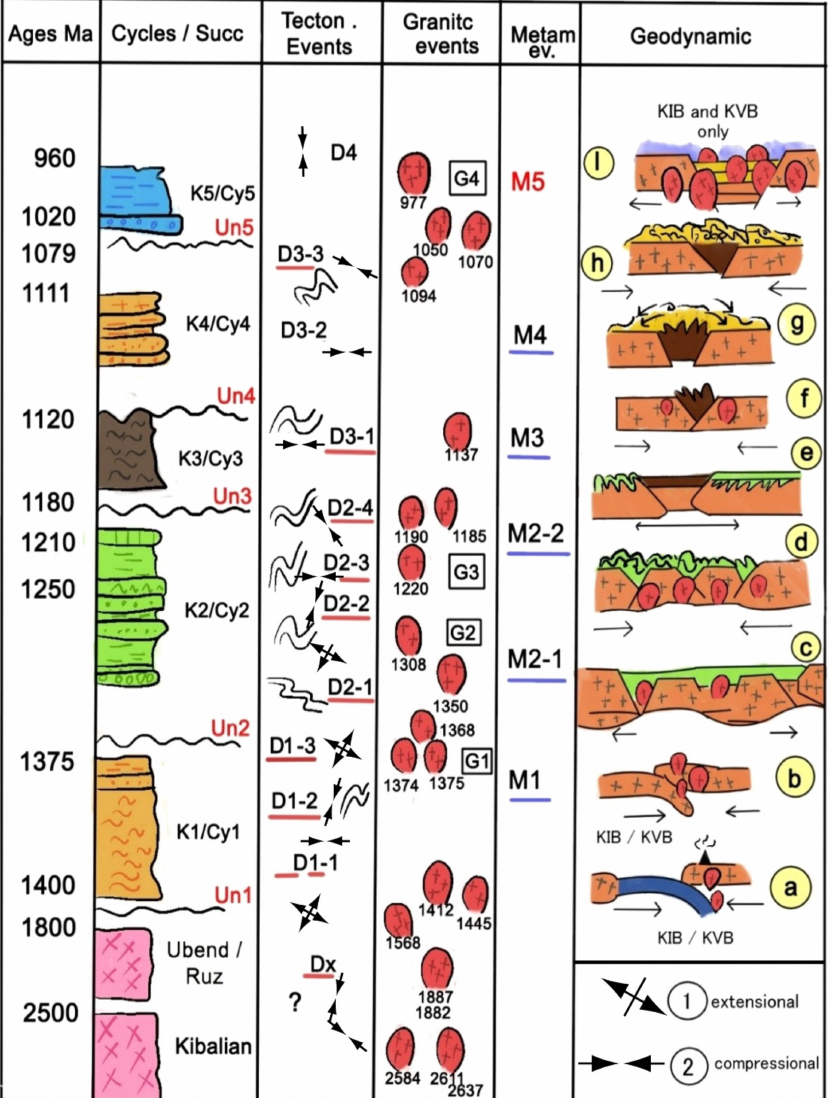
Figure 2. The main geologic events in the Kibaran belts according to [5], modified. Legend: Un = unconformity, Cy = cycles, D = tectonic events, G = granitic events, M = metamorphic events, (a) to (i) = geodynamic stages; KIB = Kibaride Belt, KAB = Karagwe-Ankolean Belt, KVB = Kivu